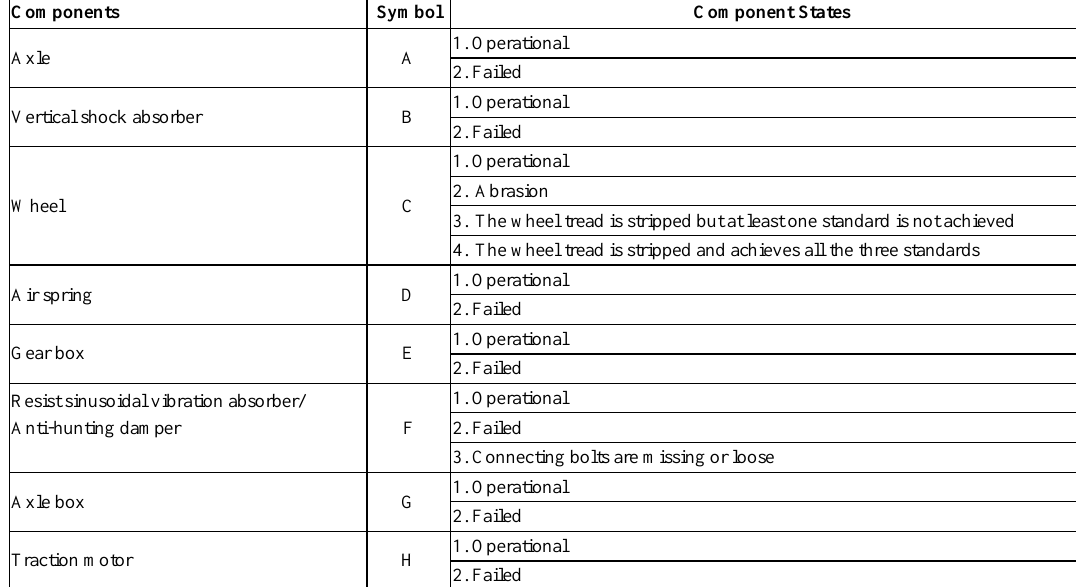
Table 1. Major components in the bogie system of a high-speed train.